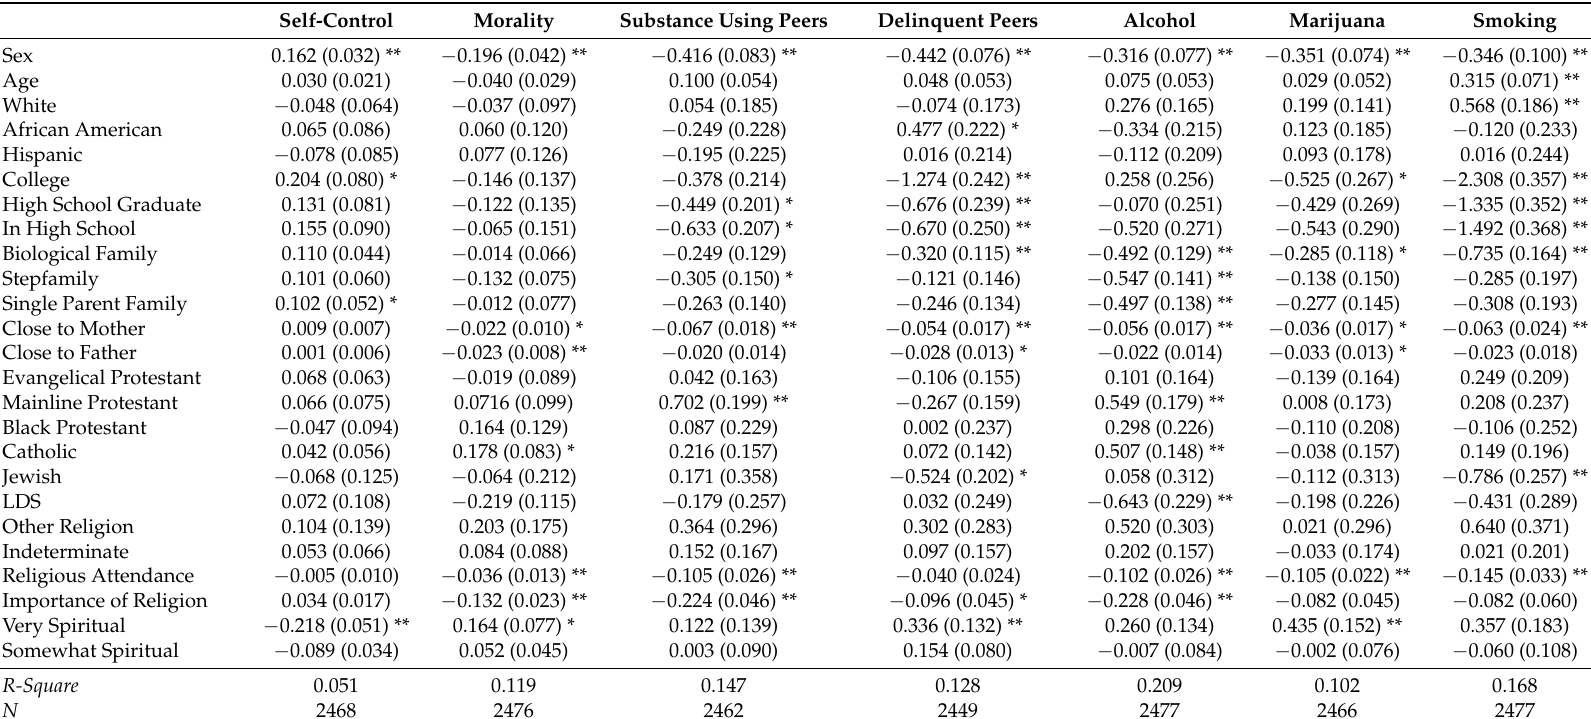
Table 2. OLS Regression of Potential Mediators on Religion (Standard